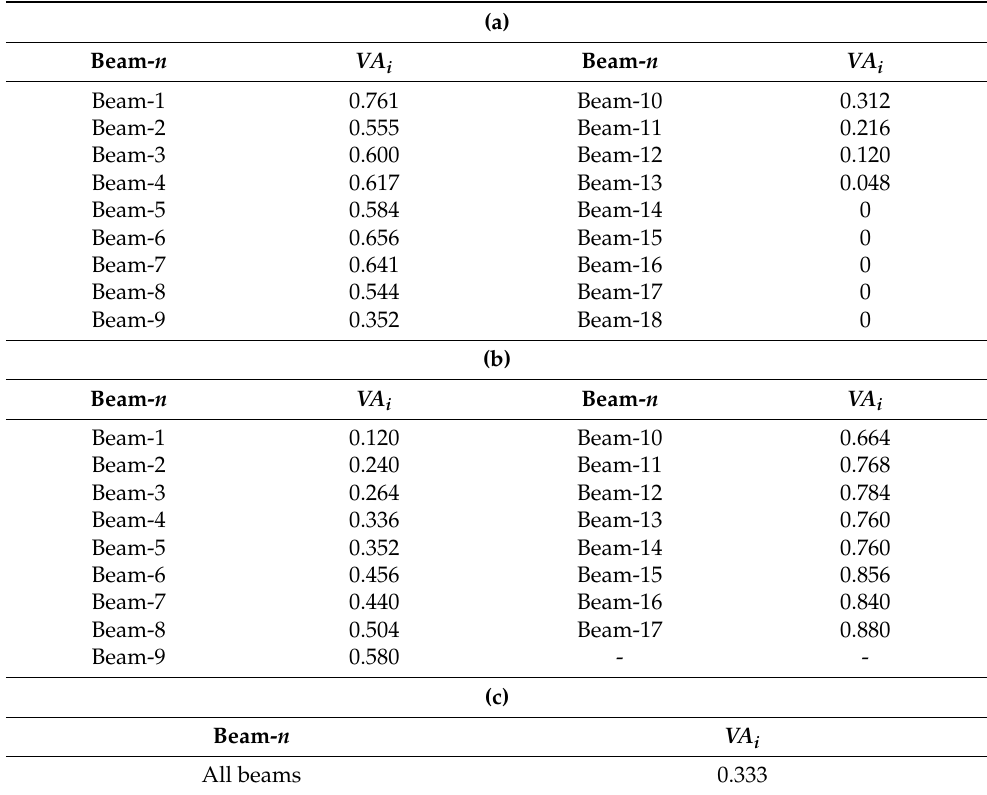
Table 5. ( a ) VA i of the 13 m span of Changhong Tunnel K1 + 812 Bridge. ( b ) VA i of Baidong No. 2 Bridge. ( c ) VA i of Yunhe Bridge.